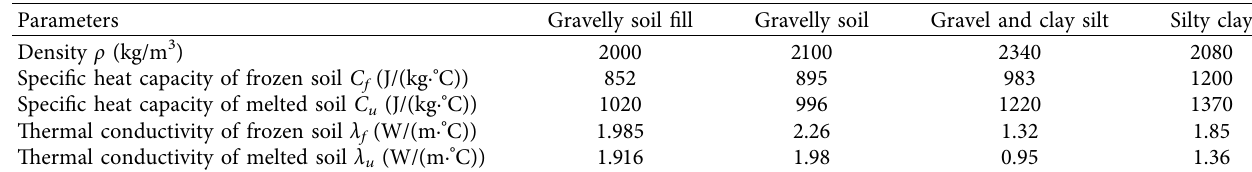
Table 2: Thermal material properties of the foundation.